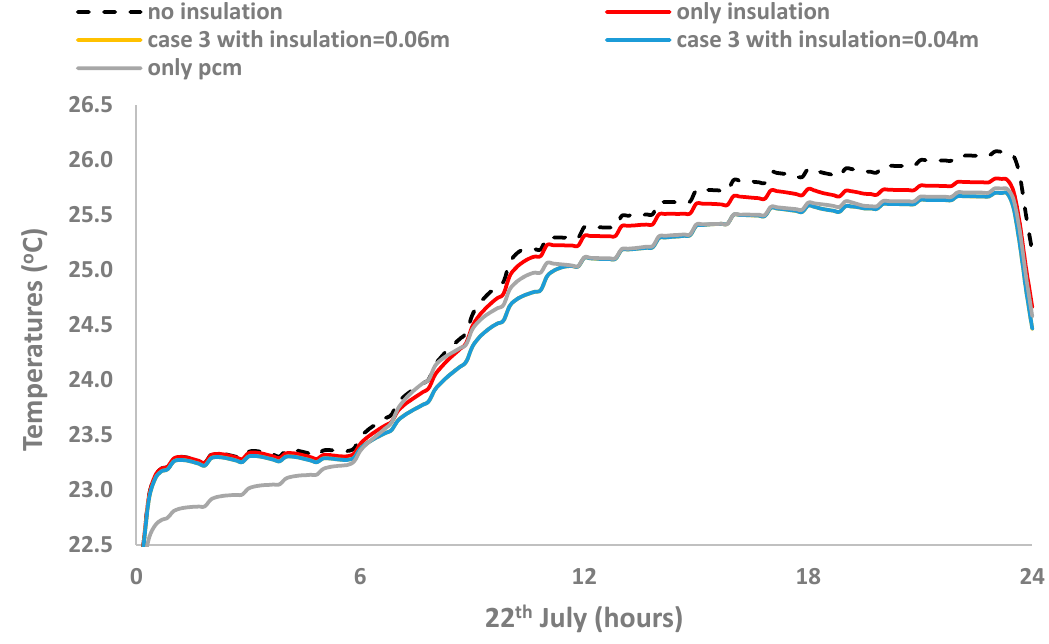
Figure 11. The temperature’s fluctuation for different cases on the warmest day of the year (22 July).